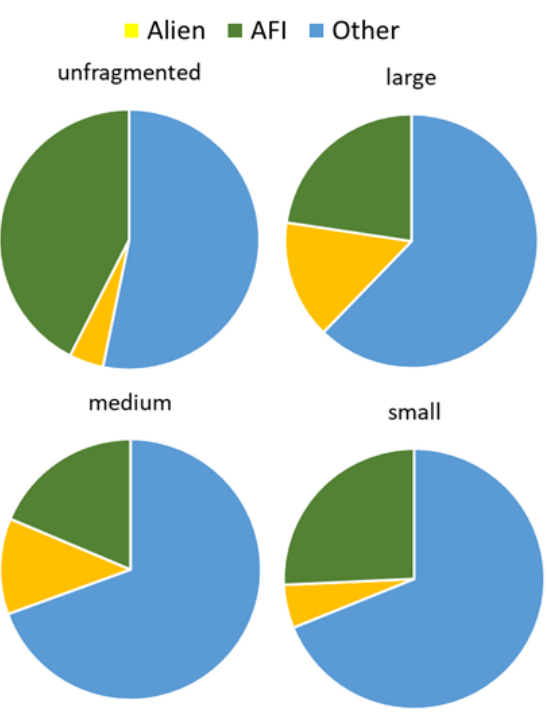
Figure 2. Plant composition quality assessed by an alien, AFI, and other plants in forest groups according to their size: unfragmented forest, large, medium, and small forest fragments.